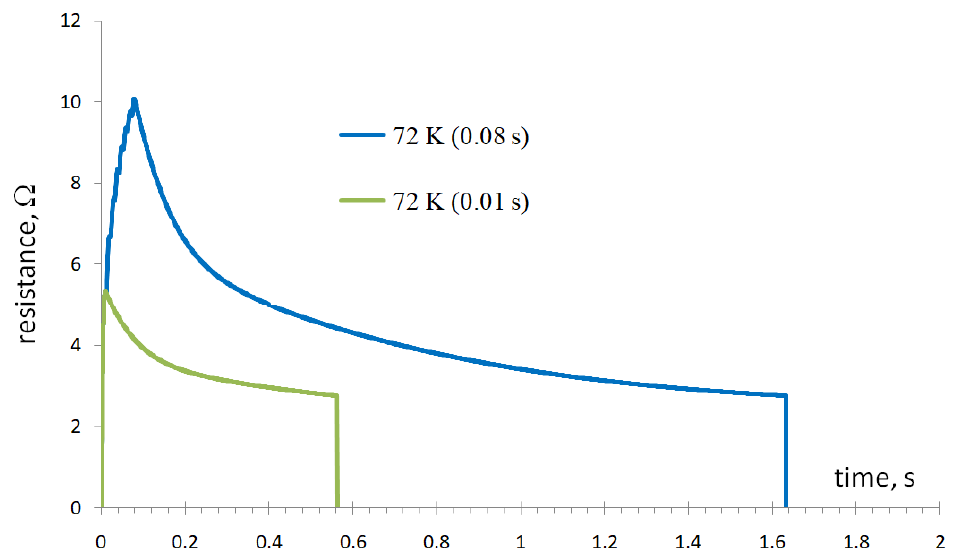
Figure 18. Changes of the HTS tape resistance of the limiter during short-circuit (0–0.08 s) and cooling down “72 K (0.08 s)” and during short-circuit (0–0.01 s) and cooling down “72 K (0.1 s)” for the initial temperature of the limiter before short-circuit = 72 K. Table 9. Maximum resistance R max of the limiter during short-circuit limitation and time of HTS tape recovery from the resistive state to the superconducting state t R-N (after the short-circuit ends) acc. Figure 18. T 0 —initial temperature, t zw —short-circuit duration.